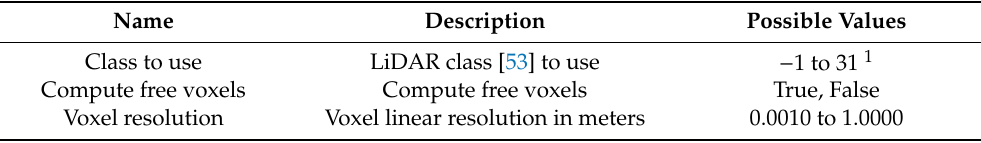
Table 5. List of the editable parameters of OctoMap.